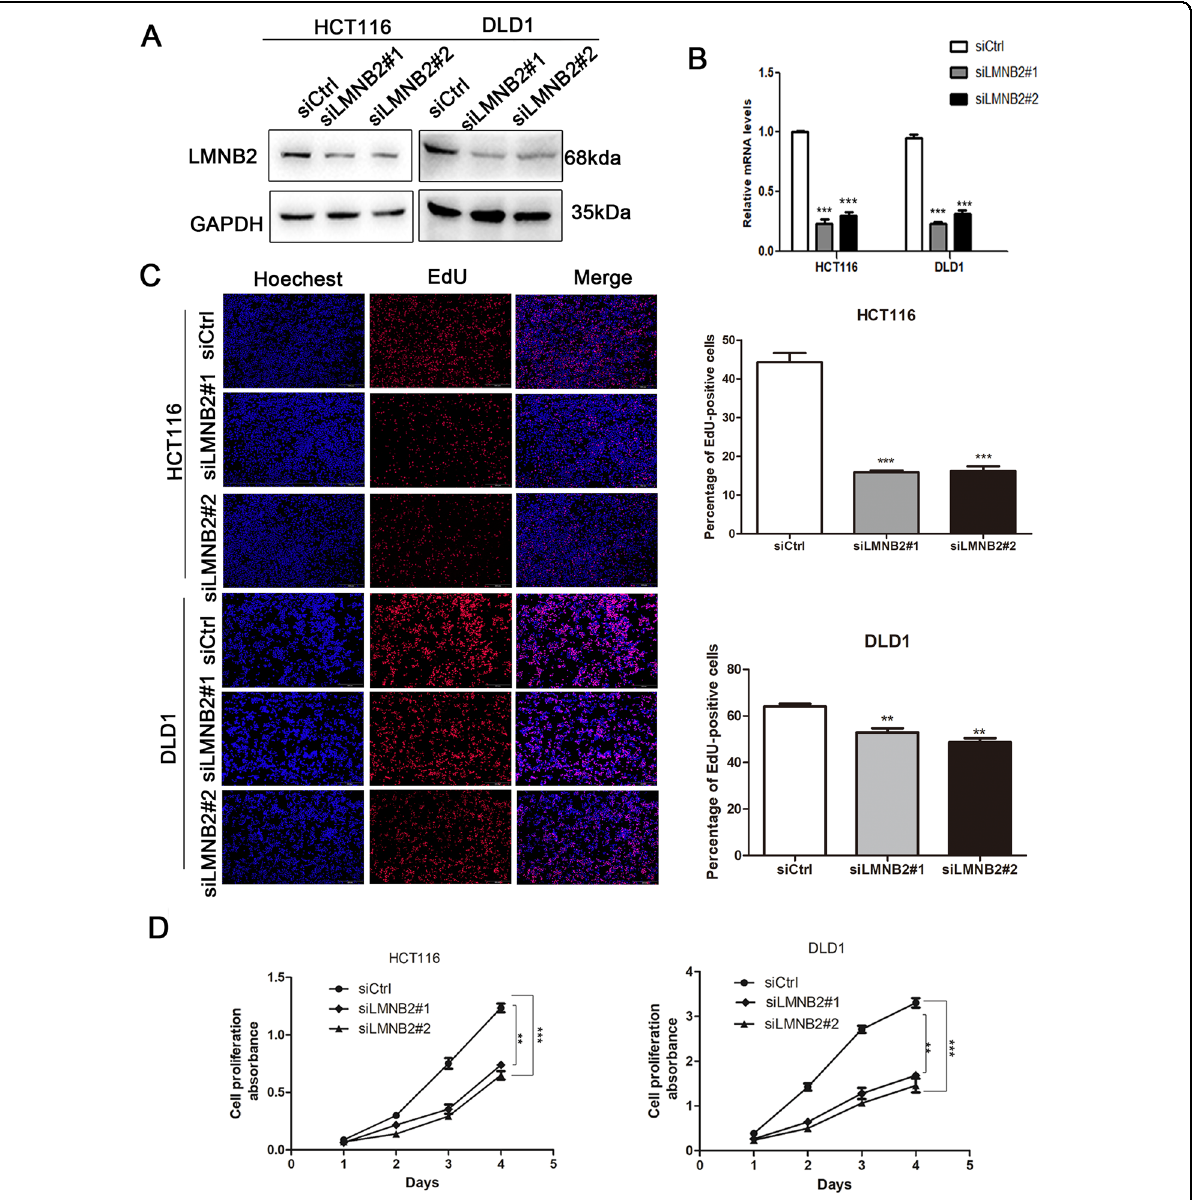
Fig. 2 LMNB2 promotes the proliferation of colorectal cancer cells. A Western blotting con fi rmed that the protein level of LMNB2 in HCT116 and DLD1 cells was downregulated. B Real-time quantitative PCR con fi rmed that the mRNA levels of LMNB2 in HCT116 and DLD1 cells were knocked out. C , D LMNB2 knockout can signi fi cantly inhibit the proliferation of HCT116 and DLD1 cells. All experiments are in triplicate. The data are shown as mean ± SD. * P < 0.05, ** P <